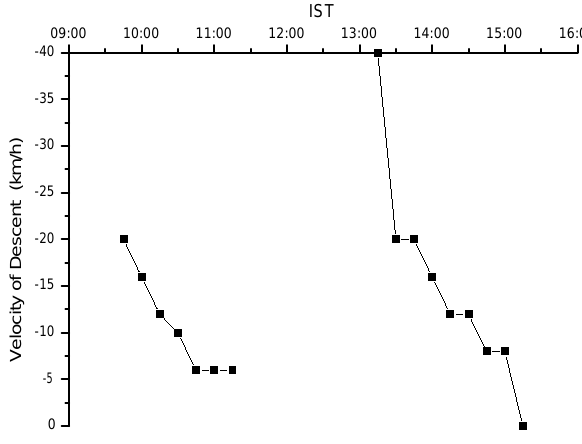
Fig. 6. Drift velocity of descending intermediate layer Es for a typ- ical day of 30 January 2004 at